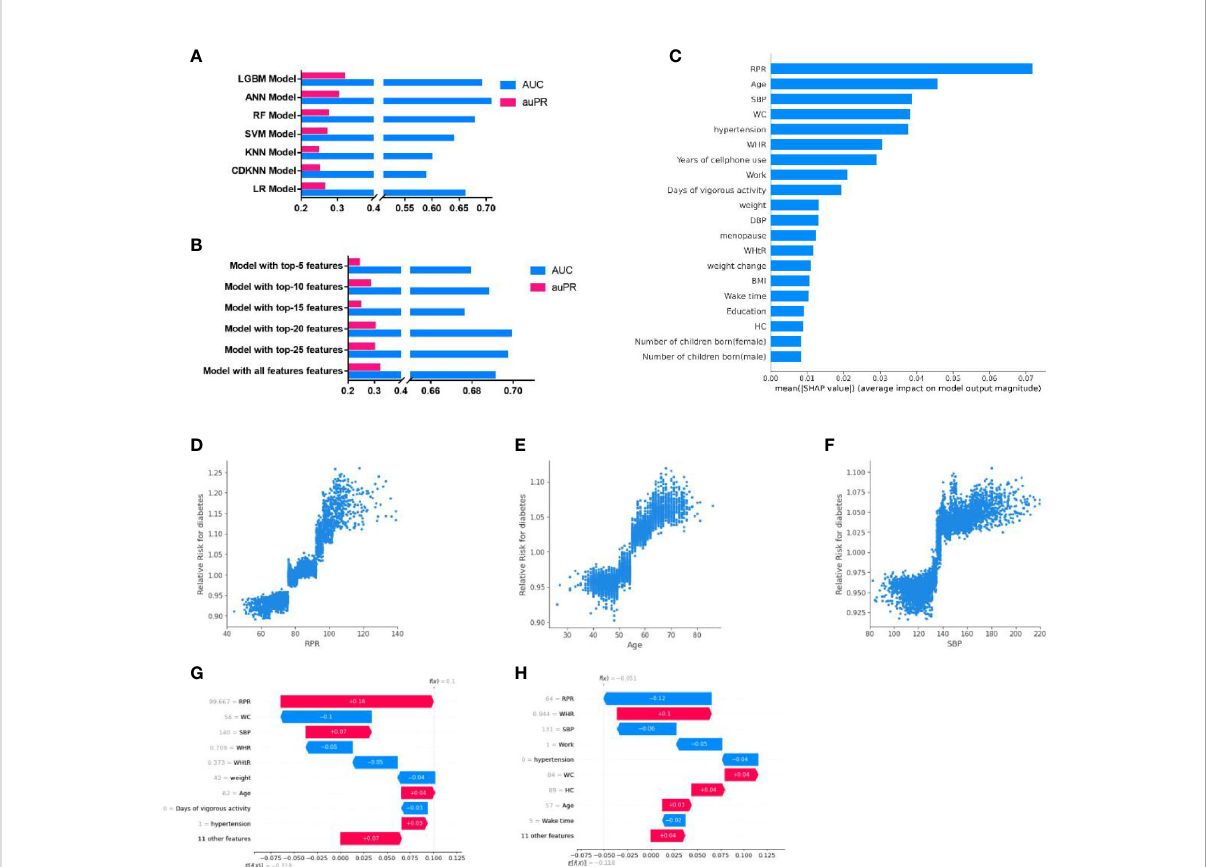
FIGURE 3 Development and interpretation of the ML model. (A) , Compared the AUC and auPR among the models with seven algorithms. (B) , Compared the AUC and auPR among streamlined models and the model with all features. (C) , Importance of the features in the ML model. The input features on the y-axis are ordered by descending importance and the values on the x-axis indicate the mean impact of each feature on model output magnitude based on SHAP analysis. (D – F) , The relative risk of diabetes of RPR (D) , Age (E) , and SBP (F) . Each point represented the predicted relative diabetes risk of each individual. The relative risk value above 1·0 for speci fi c features represent an increased risk of diabetes. (G-H) , Personalized risk prediction for two cases from the validation set of the ML model. The y-axes represent the input features ordered by descending importance. f(x) is the personalized model output for a participant. If f(x) is larger than e[f(x)], the patient has a higher risk of diabetes relative to the background population. Each arrow represents how a speci fi c feature increases (red) or decreases (blue) the participant ’ s risk for diabetes. LGBM, light gradient boosting machine; ANN, Arti fi cial Neuron Network; RF, Random Forest; SVM, Support Vector Machine; LR, Logistic Regression; KNN, K-nearest neighbors algorithm; CDKNN, Centroid-Displacement-based-k-NN; RPR, resting pulse rate; WHR, waist- to-hip ratio; SBP, systolic blood pressure; BMI, body mass index; WC, waist circumference; WHtR, waist-to-height ratio; DBP, diastolic blood pressure; HC, hip